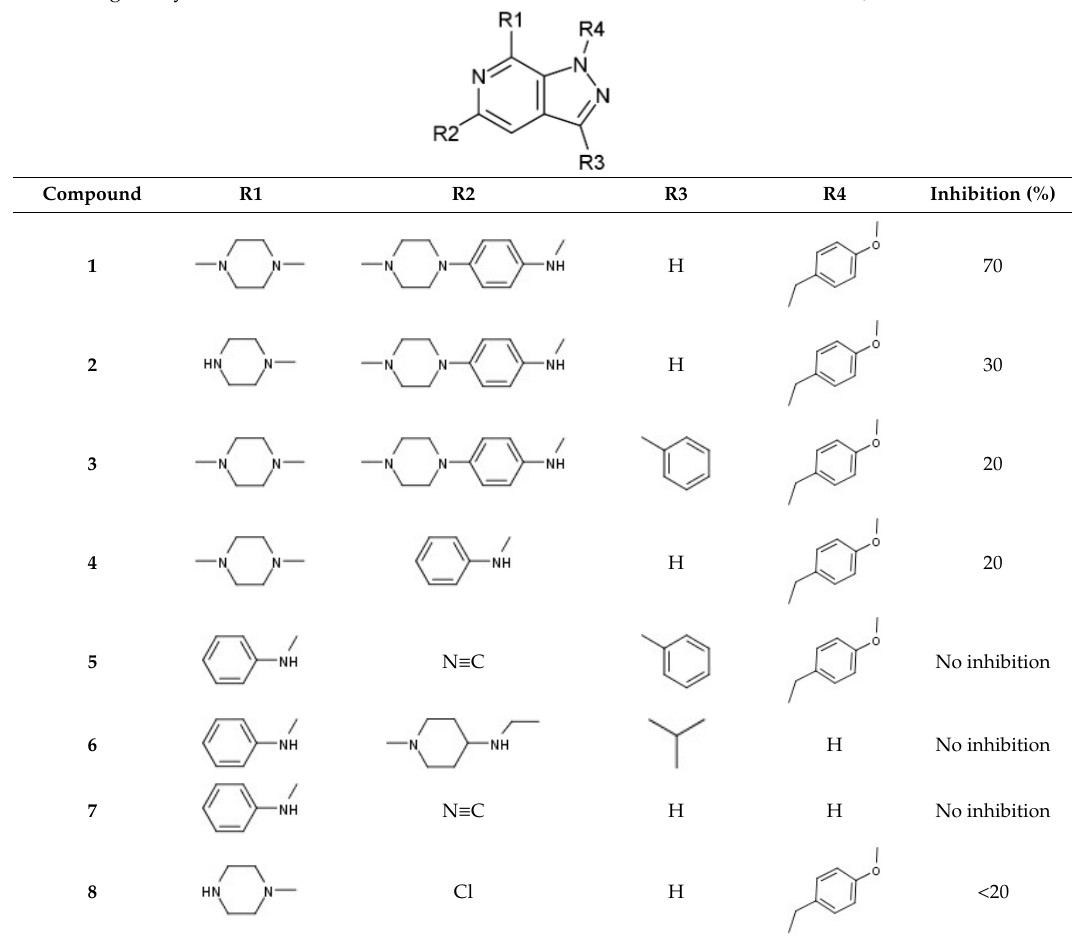
Table 1. The inhibitory activity of the 8 pyrazolo[3-c], pyridine derivatives against full length CBS. Percentage enzyme inhibition was measured at a final inhibitor concentration of 100 μ M.